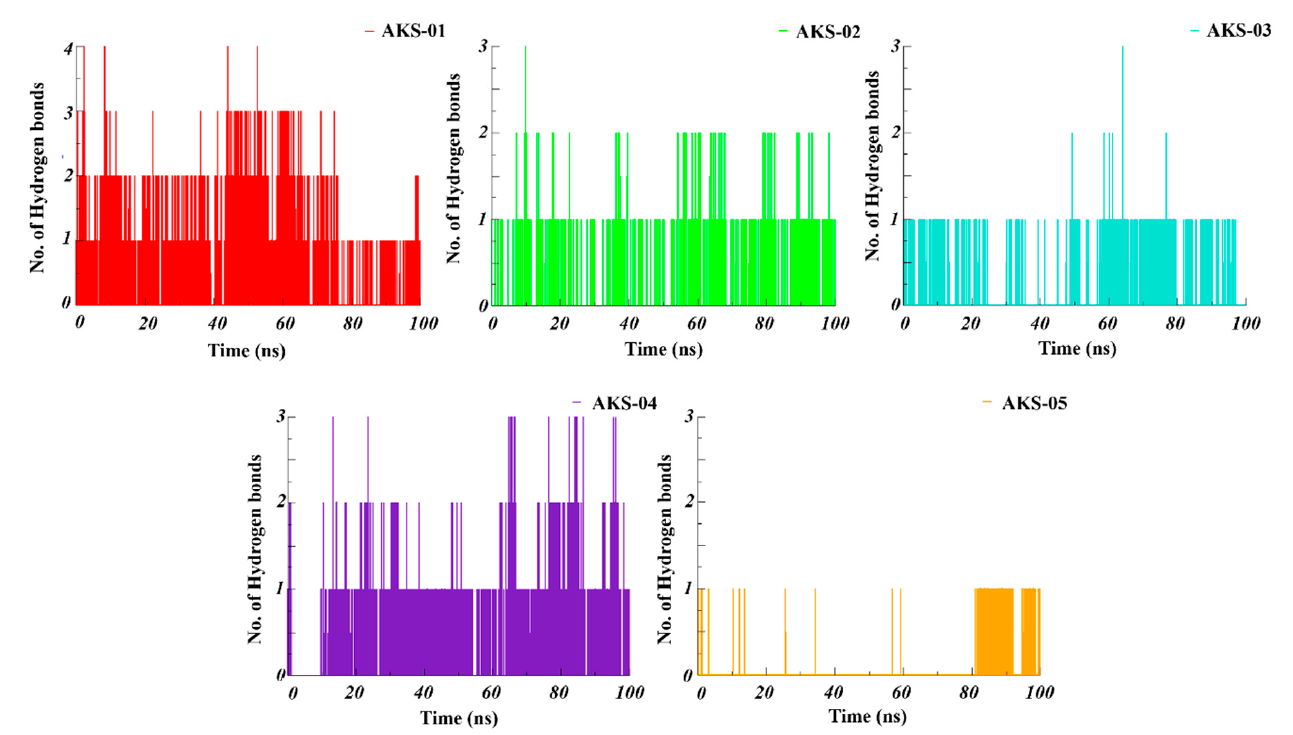
Figure 7. Radius of Gyration of Apo (Omicron’s RBD) and five selected compounds in complex with RBD over the 100 ns of simulation time.